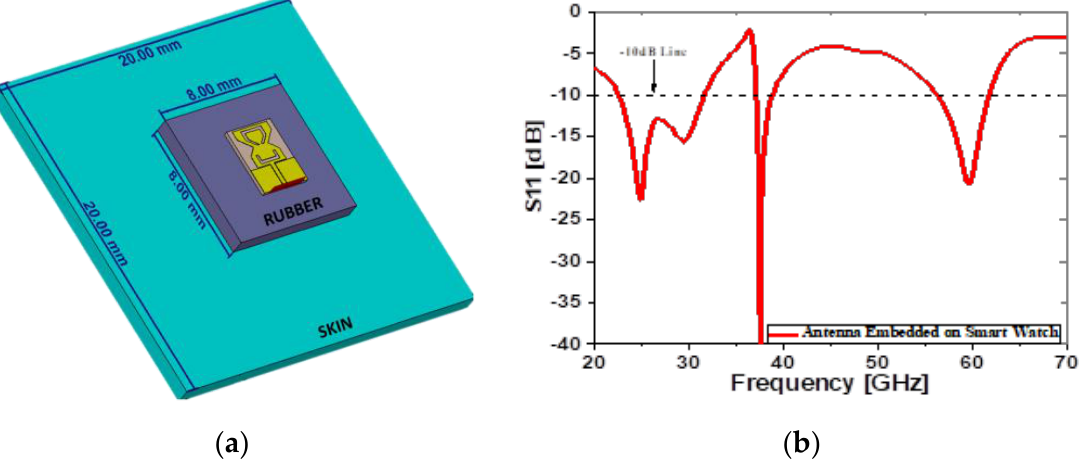
Figure 10. ( a ) Proposed antenna over rubber and skin tissues; ( b ) simulated return loss.